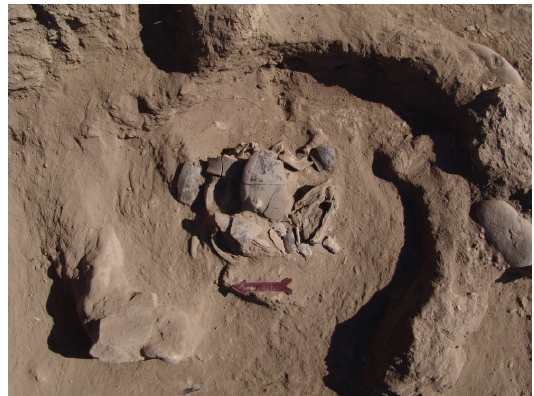
Figure 2. Shengavit: excavations of the 4th tomb